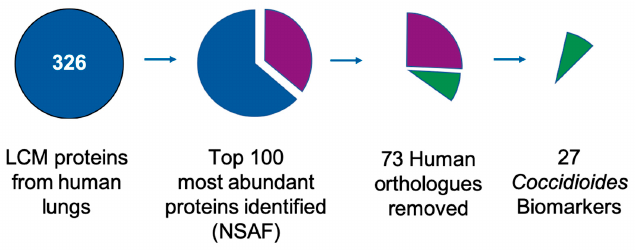
Figure 2. Laser capture microdissection (LCM) assisted biomarker discovery flowchart. There were a total of 326 Coccidioides spp. proteins identified in infected human lung tissues by mass spectrometry. Proteins with the 100 highest normalized spectral abundance factors (NSAFs) were further evaluated for orthology to human proteins (pBLAST > 40% identity). Seventy-two human orthologues were removed, leaving 27 Coccidioides spp. biomarker candidates.